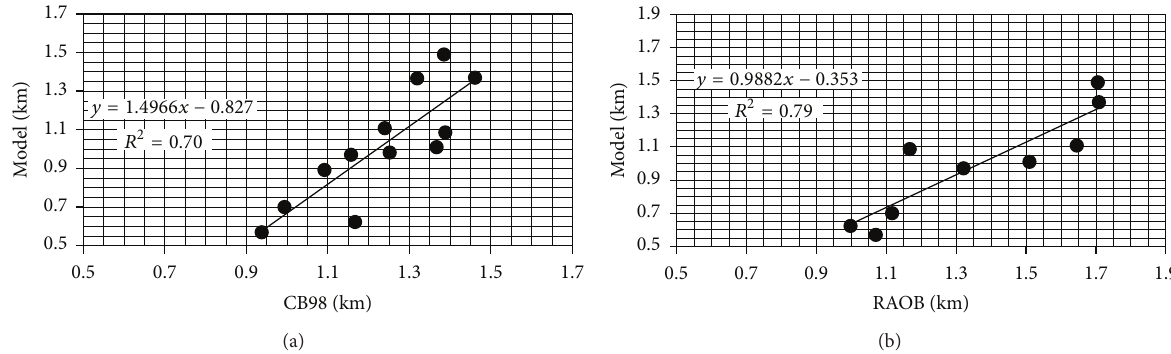
Figure 5: Comparison of monthly mean PBLH. The same KWRF Model PBLH is evaluated by (a) 10-year radiosonde data [18] and (b) 1-year (June 2010–May 2011) radiosonde data [19]. In (b), summer season RAOB data were not used due to low availability as a result of monsoon